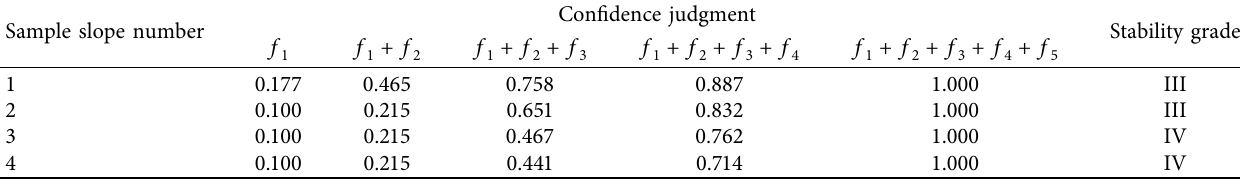
Table 9: Evaluation results of slope stability by confidence